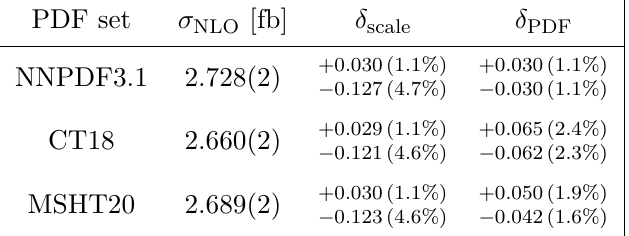
Table 3 . Integrated fiducial cross section at NLO in QCD for the pp → e + ν e µ − ¯ ν µ b ¯ b H process at √ the LHC with s = 13 TeV. Results are given for µ 0 = H T / 2 as well as for NNPDF3.1, CT18 and MSHT20 PDF